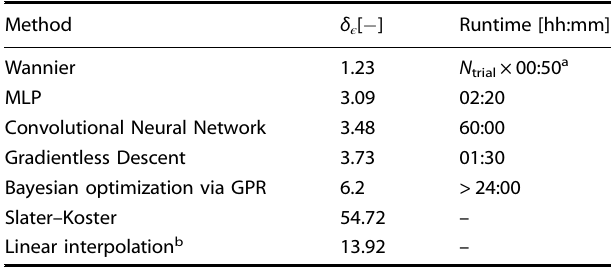
Table 1. ML comparison: comparing performance [in terms of BS error fi ciency of several ML approaches to the δ ε , see Eq. (5)] and time ef inverse BS problem of the double vacancy in SLG.